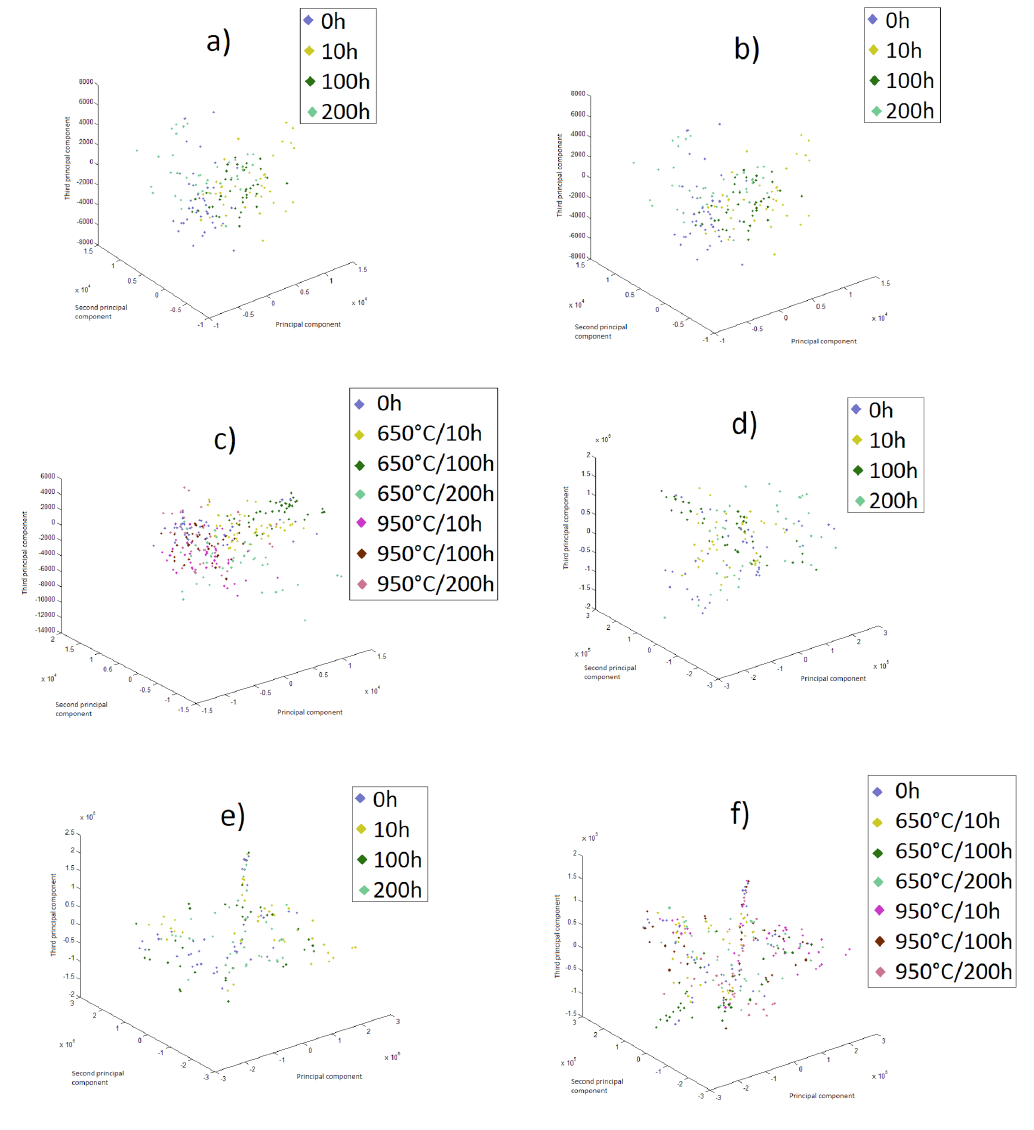
Figure 1. Spatial distribution of the samples of the ( a ) 4-MHz backscattered signals at 650 ◦ C, ( b ) 950 ◦ C and ( c ) of both temperatures together and of the ( d ) pulse echo signals at 650 ◦ C, ( e ) 950 ◦ C and ( f ) of both temperatures